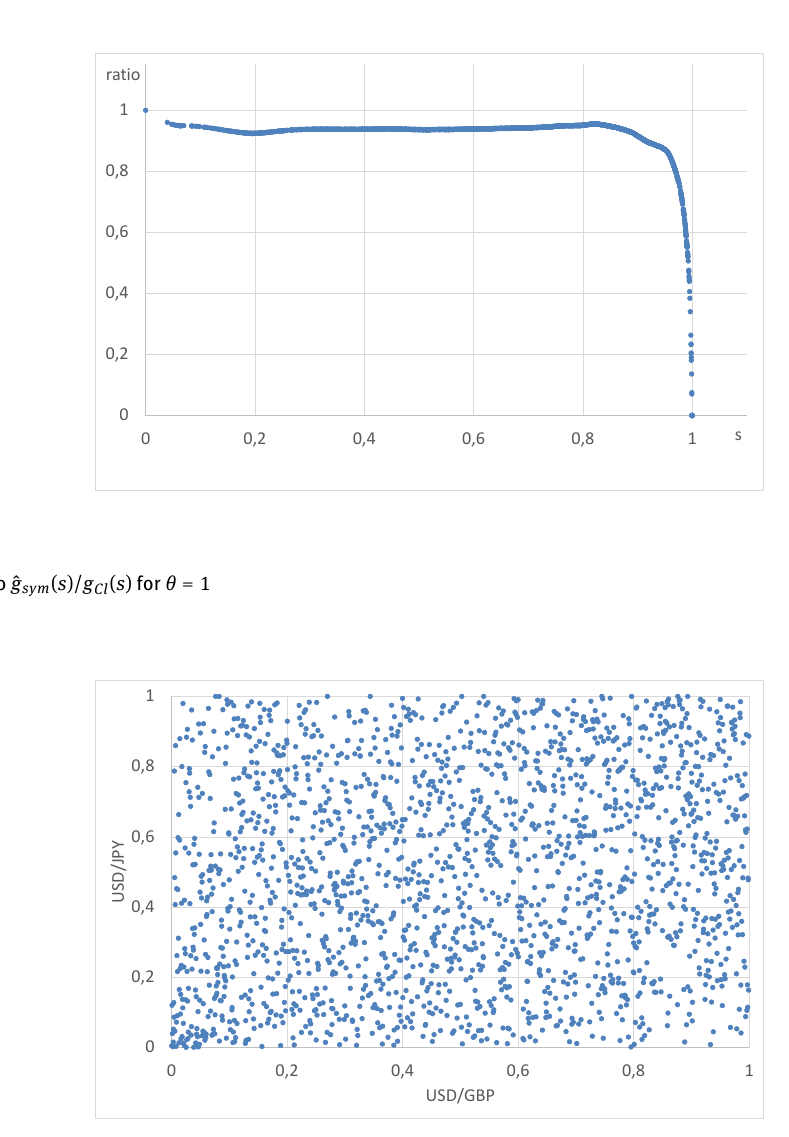
Figure 2: Scatter plot for the truncated survival